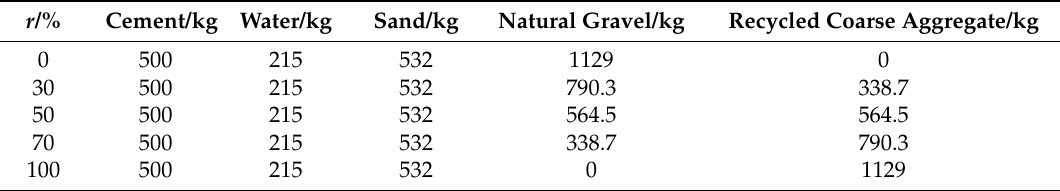
Table 1. Mix proportions of recycled